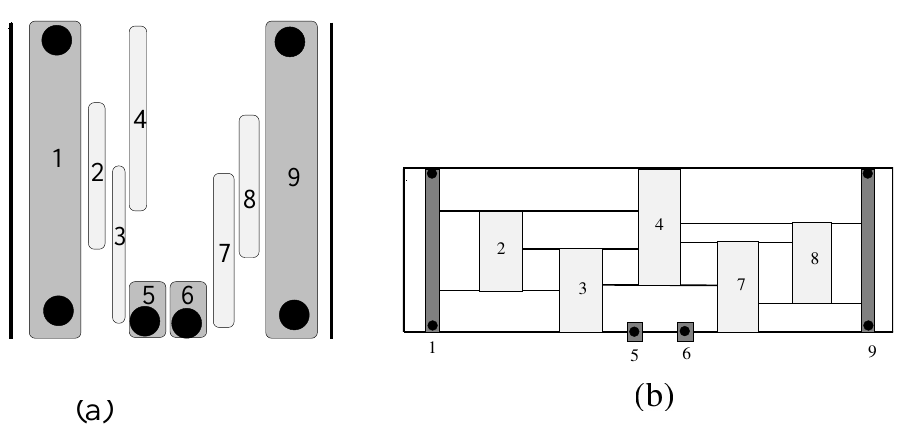
Figure 19. ( a ) Ordered vertical objects; ( b ) their separation visibility